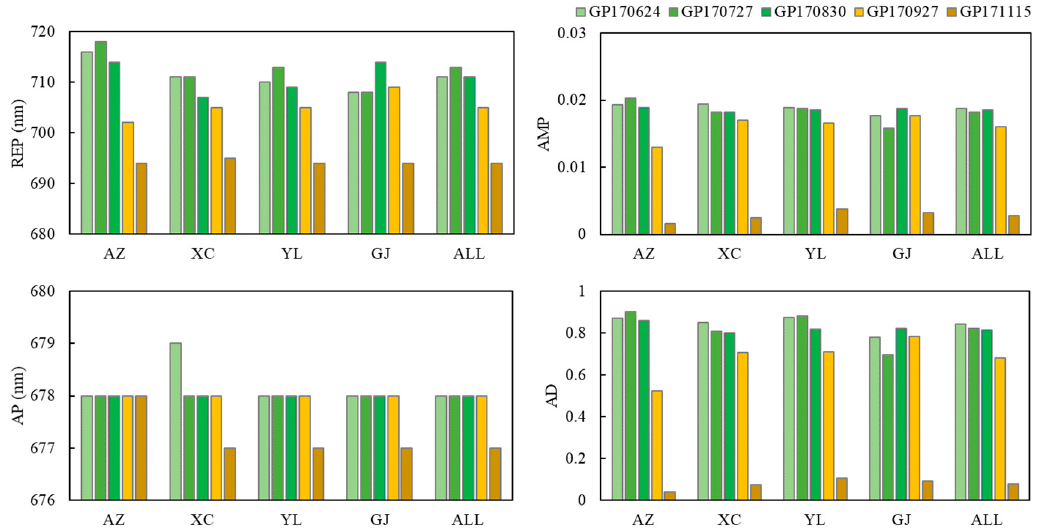
Figure 3. Change rule of the spectrum feature parameters (REP, AMP, AP, and AD) throughout the alpine grassland growth period (June to November). Higher AD values correspond to more obvious absorption features. Each sample area (i.e., AZ, XC, YLJ, and GJ) includes five sample plots. ALL represents all the samples ( n = 100).